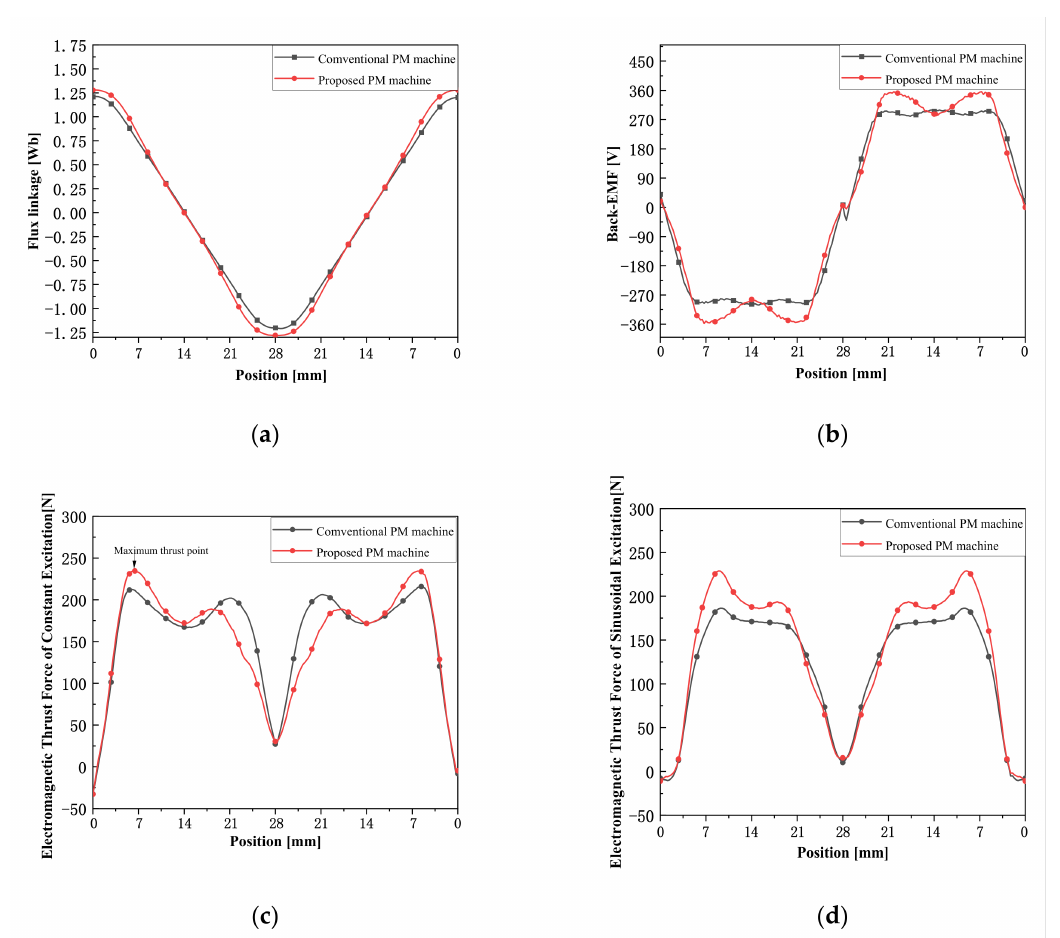
Figure 5. Characteristics comparison of the conventional model 1 and the proposed model 2: ( a ) Flux linkage waveforms; ( b ) back-EMF waveforms; ( c ) Electromagnetic thrust force under constant DC current excitation; ( d ) Electromagnetic thrust force excited by sinusoidal